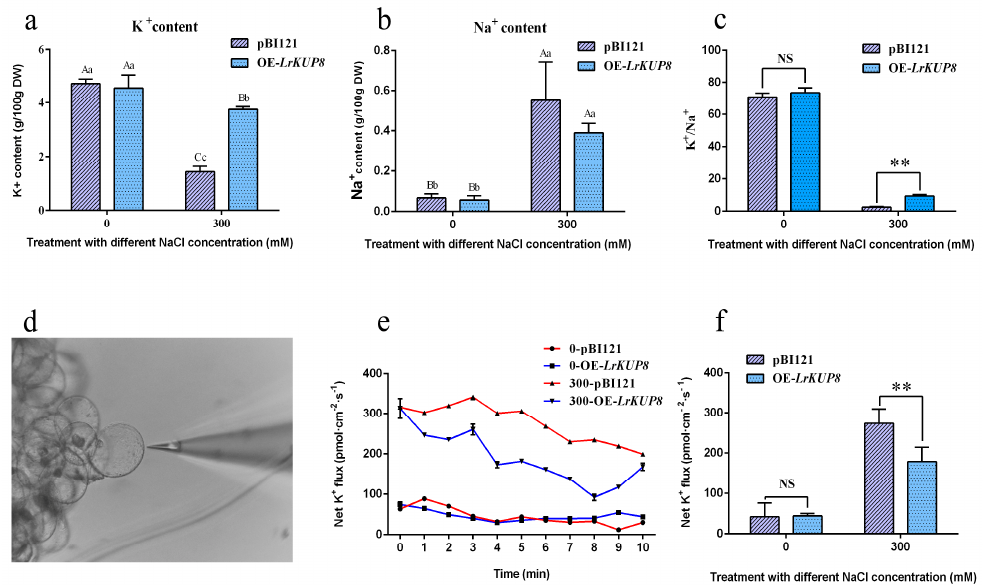
Figure 5. LrKUP8 reduces K + efflux in calli. ( a ) K + content of L. ruthenicum calli with 300 mM NaCl for 50 days expressing GFP or LrKUP8-GFP . The data is from three samples ( n = 3). ( b ) Na + content of L. ruthenicum calli with 300 mM NaCl for 50 days expressing GFP or LrKUP8-GFP . The data is from three samples ( n = 3). ( c ) K + / Na + ratios of L. ruthenicum calli with 300 mM NaCl for 50 days expressing GFP or LrKUP8-GFP . The data is from three samples ( n = 3). ( d ) The measuring position using K + -selective microelectrode of NMT. ( e ) K + flux rates measured by NMT / MIFE assays of L. ruthenicum calli expressing GFP or LrKUP8-GFP under control or 300 mM NaCl treatment after 12 h. The data is from six samples ( n = 6). ( f ) Histogram analyses of K + in L. ruthenicum calli expressing GFP or LrKUP8-GFP under control or 300 mM NaCl treatment after 12 h. The data is from six samples ( n = 6). The mean ± SE of all replicates is presented. The upper- and lowercase letters on the histogram indicate p < 0.01 and p < 0.05, respectively. The double asterisks represent p < 0.01. NS means not significant.4.